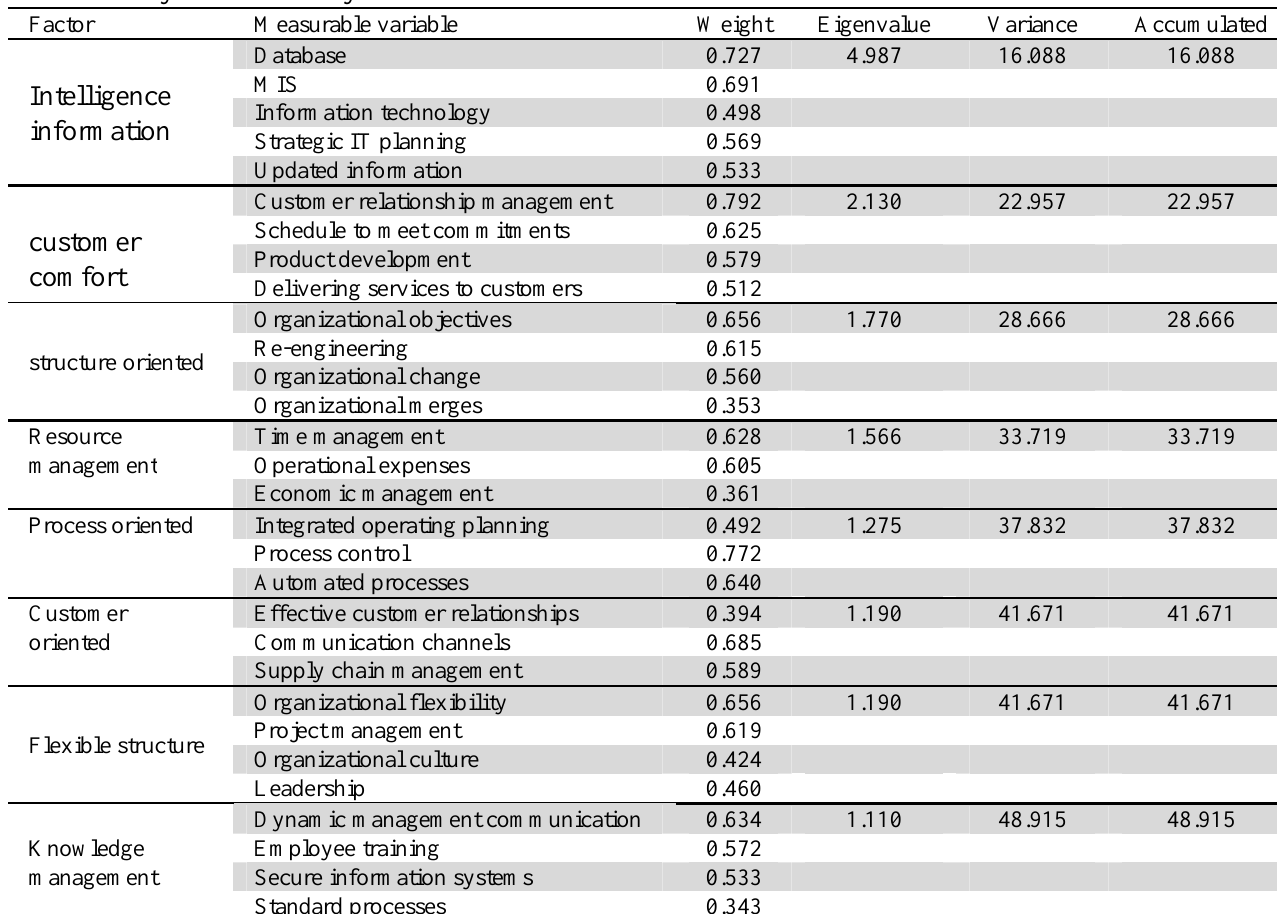
Table 3 The summary of factor analysis